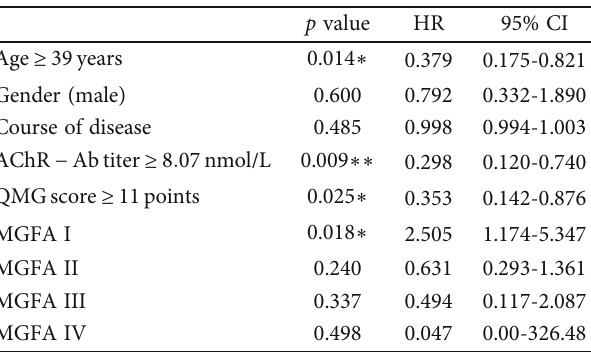
Table 5: Cox regression analysis of MG subtype treatment